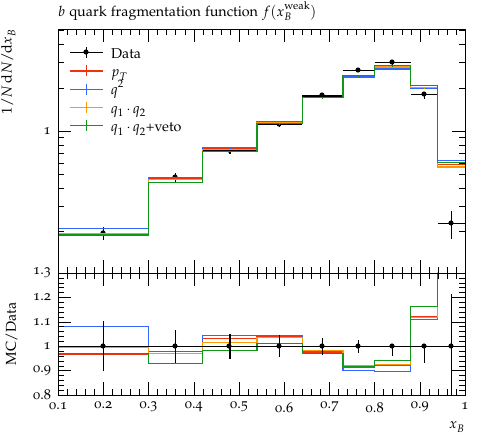
Figure 9 . Fragmentation function of weakly-decaying B -hadrons compared with data from DELPHI